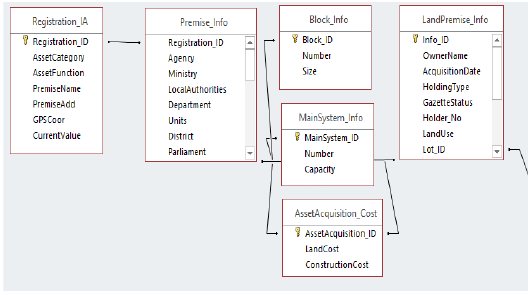
Figure 8: Example of Database design based on